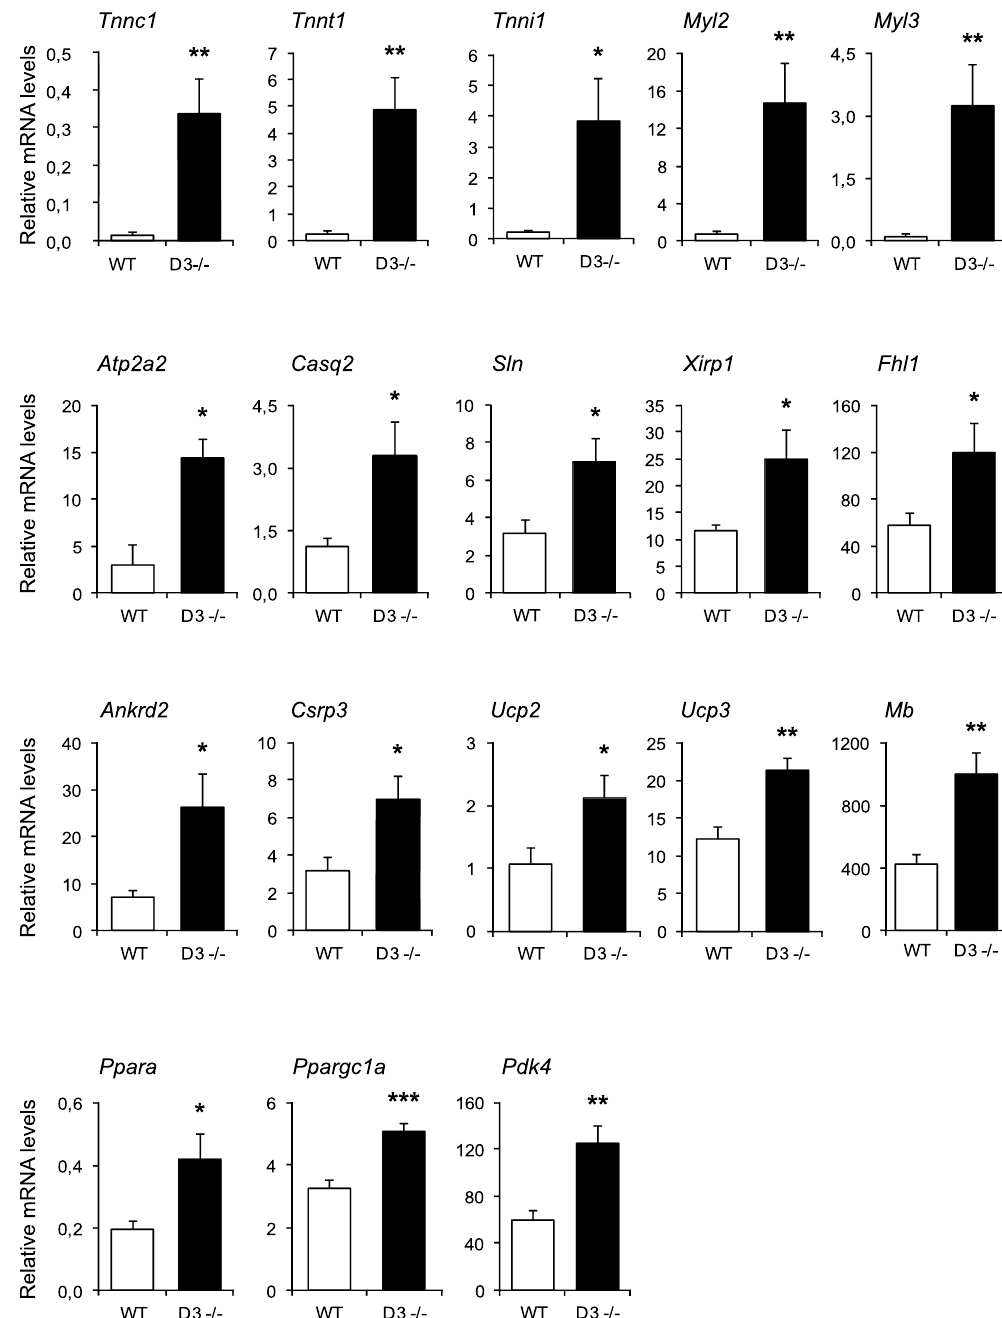
Figure 6. Validation by RT-qPCR of representative cyclin D3 target genes. Expression analysis by RT-qPCR of selected genes in quadriceps muscles isolated from adult D3 − / − and WT mice (n = 7). mRNA levels are expressed relative to TBP (TATA binding protein) mRNA, used as endogenous control. Data are reported as means ± SEM. Statistical differences between WT and D3 − / − mice was assessed by two-tailed unpaired t-tests ( ** p < 0.01, *** p <